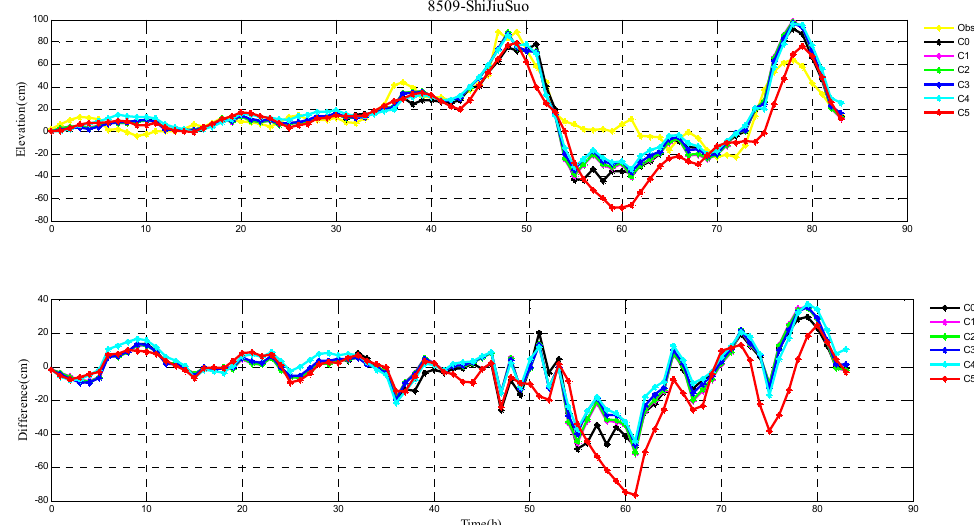
Figure 7. The storm surge elevations (cm) in six cases (C0, C1, C2, C3, C4, C5) and observations (yellow line) (top) and the differences between them (bottom) during Typhoon 8509 at ShiJiuSuo tide station.